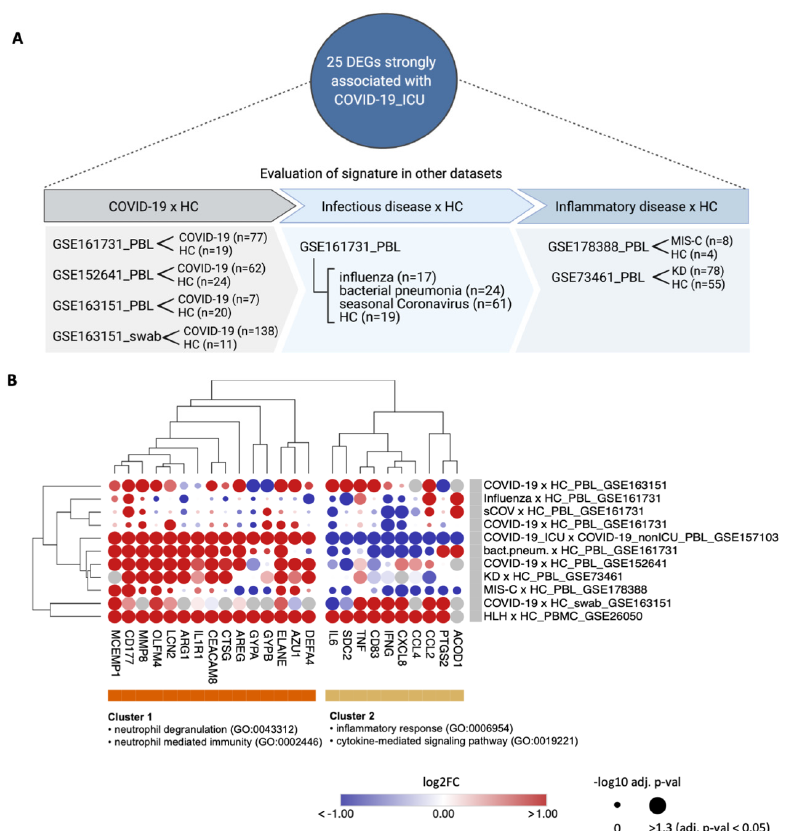
Figure 4. Transcripts stratifying severe COVID-19 from other respiratory diseases and HLH from healthy controls. ( A ) Schematic overview of study design and patient classification of dataset GSE157103 reported by Overmyer et al. [26]. Created with BioRender.com. ( B ) Protein-protein in- teraction (PPI) network highlighting interactions among the 158 proteins and the 25 genes signifi- cant for severe COVID-19_ICU, while keeping their other interacting partners ( n = 9921) in the mid- dle circle. The node colour denotes Gene Ontology Biological Process terms. The left circle shows 123 proteins and 554 interactions, the upper right half circle shows 21 proteins and 29 interactions, and the lower right side half circle shows 25 proteins and 65 interactions. Molecules involved in neutrophil-mediated immunity are highlighted with a blue node outline. ( C ) Correlation matrices of the 25 DEGs in controls and COVID-19 groups (Controls, left matrix; COVID-19_nonICU, middle matrix; and COVID-19_ICU, right matrix). The color scale bar represents the Pearson’s correlation coefficient, containing negative and positive correlations from − 1 to 1, respectively. ( D ) Scatter plots with marginal boxplots display the relationship between the eight genes stratifying severe COVID- 19. Correlation coefficient ( ρ ) and significance level ( p -value) for each correlation is shown within each graph. ( E ) Principal Component Analysis (PCA) with spectral decomposition shows the strat- ification of COVID-19_ICU from COVID-19_nonICU and other respiratory diseases (Control_no- nICU and Control_ICU). Variables with positive correlation are pointing to the same side of the plot, contrasting with negative correlated variables, which point to opposite sides. Confidence ellipses are shown for each group/category. Bar plots associated with the PCA represent the sample distri- bution across the PCA axes. ( F ) PCA displaying the stratification of HLH patients and healthy con- trols is based on the same 25 DEGs as in ( E ).